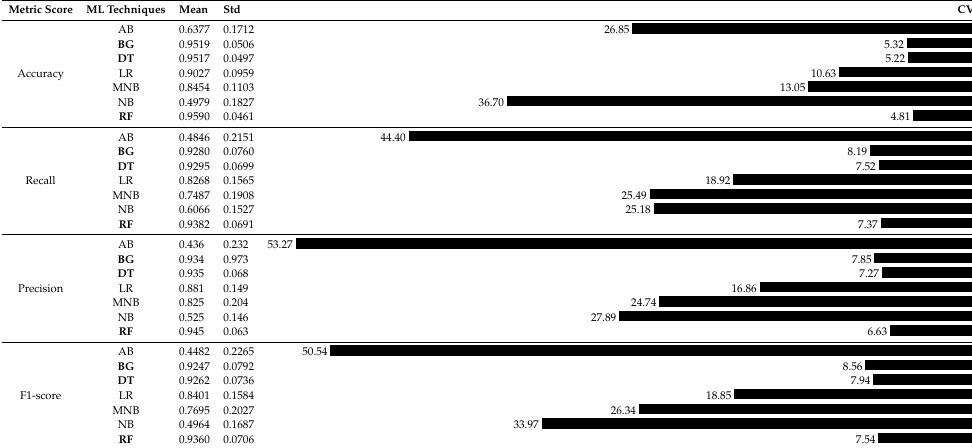
Table 9. The statistics of performance metrics.